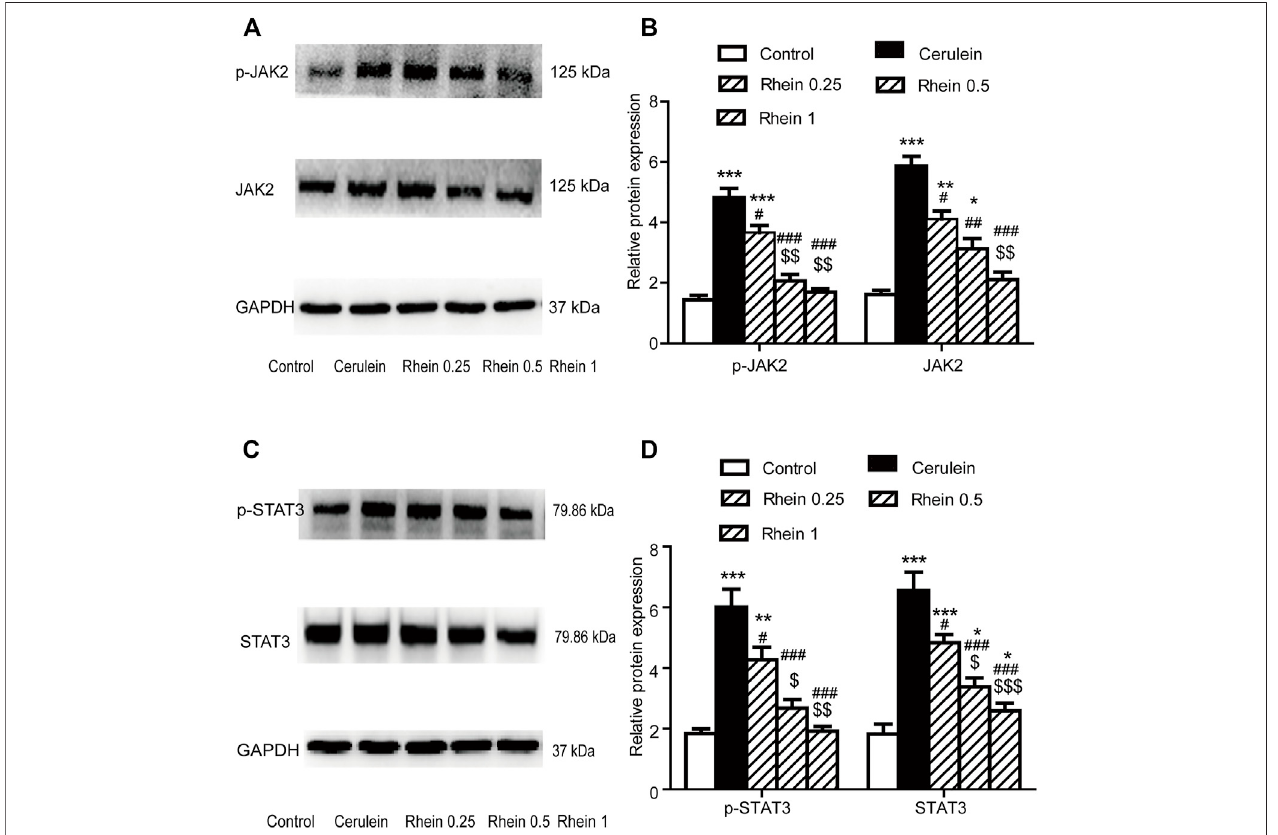
FIGURE8| Theproteinexpressionofp-JAK2,JAK2,p-STAT3andSTAT3intheAR42Jcellmodelwasmeasuredbywesternblot. (A,B) p-JAK2andJAK2protein expression in the control, cerulein, rhein 0.25 μ g/ml, rhein 0.5 μ g/ml and rhein 1 μ g/ml groups. (C,D) p-STAT3 and STAT3 protein expression in the control, cerulein, rhein0.25 μ g/ml,rhein0.5 μ g/mlandrhein1 μ g/mlgroups.Dataareexpressedasmean±SD( n =5pergroup).Signi fi cancebetweengroupswasevaluatedbyoneway analysisofvariance (ANOVA) followed by aTukeypost hoc test. * p < 0.05, ** p < 0.01 and *** p < 0.001 compared with thecontrol group; # p < 0.05, ## p < 0.01 and ### p < 0.001 compared with the cerulein group; $ p < 0.05, $$ p < 0.01 and $$$ p < 0.001 compared with the rhein 0.25 μ g/ml group. JAK2, janus kinase two; STAT3, signal transducer and activator of transcription